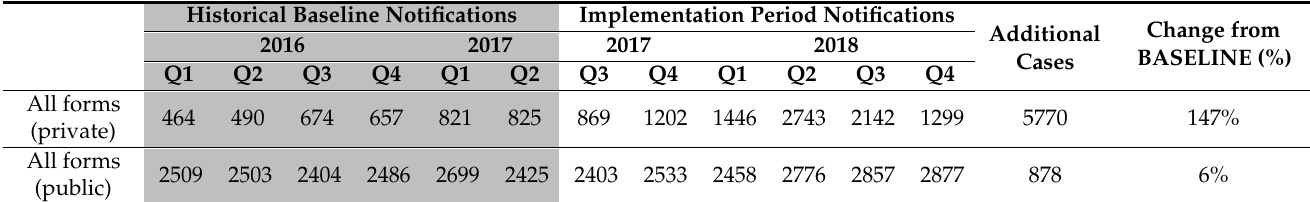
Table 4. Notifications in the National TB Elimination Program in the private project intervention area between January 2016 and December